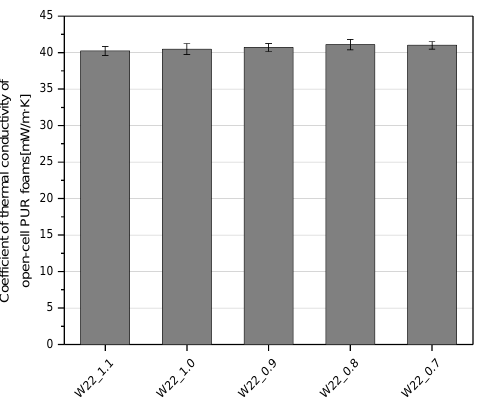
Figure 11. The coefficient of thermal conductivity of the open-cell PUR foams with different NCO indices.